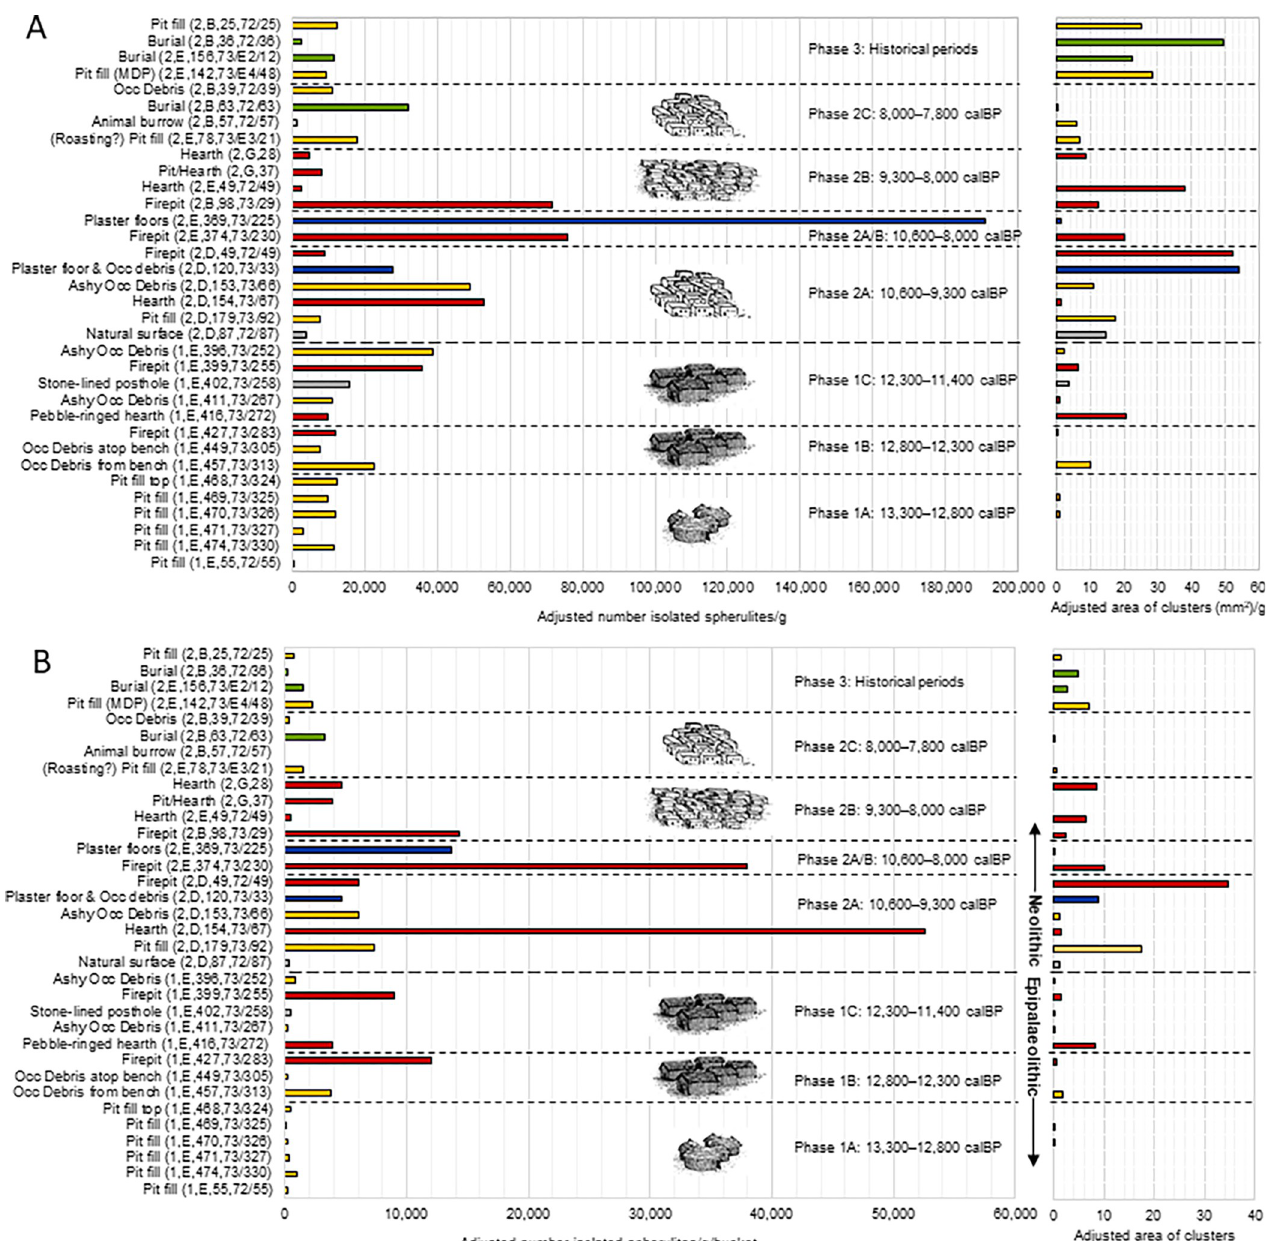
Fig 6. Bar charts illustrating the adjusted number of isolated spherulites (left) and adjusted area of clusters (right) per sample. The values presented are adjusted: A) per g of sample examined; and B) per g of sample examined/bucket of sediment to enable transparent comparison. Samples are organized from youngest (top) to oldest (bottom) following the Harris matrices from Abu Hureyra. Architectural and settlement trends for each phase of occupation are also illustrated. Key to color coding of bars: yellow = occupational debris and pitfill; red = pyric features (including hearths and firepits); blue = plaster floors; green = burials; grey = other (context details, including trench, level, and feature type, are noted in the y-axis sample labels).